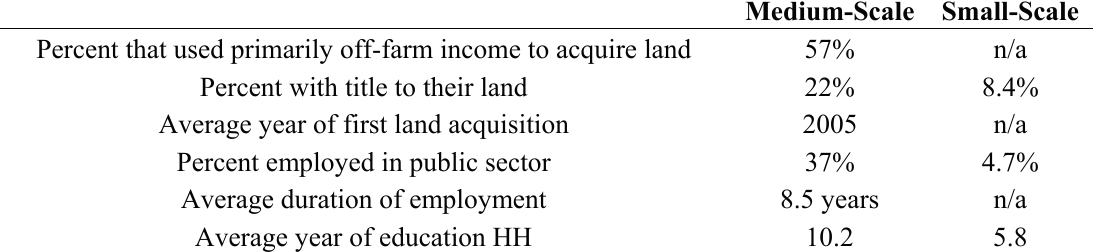
Table 3. Socio-economic comparisons of medium-scale and small-scale land owners. Source: medium-scale farmer data comes from Sitko and Jayne 2014 (N=183), small-scale data comes from RALS